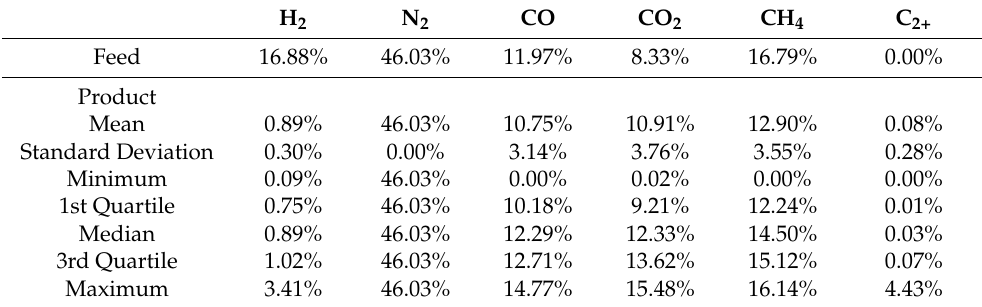
Table A1. Product gas composition from the Halite Reactor. Product gas compositions are normalised to the feed gas